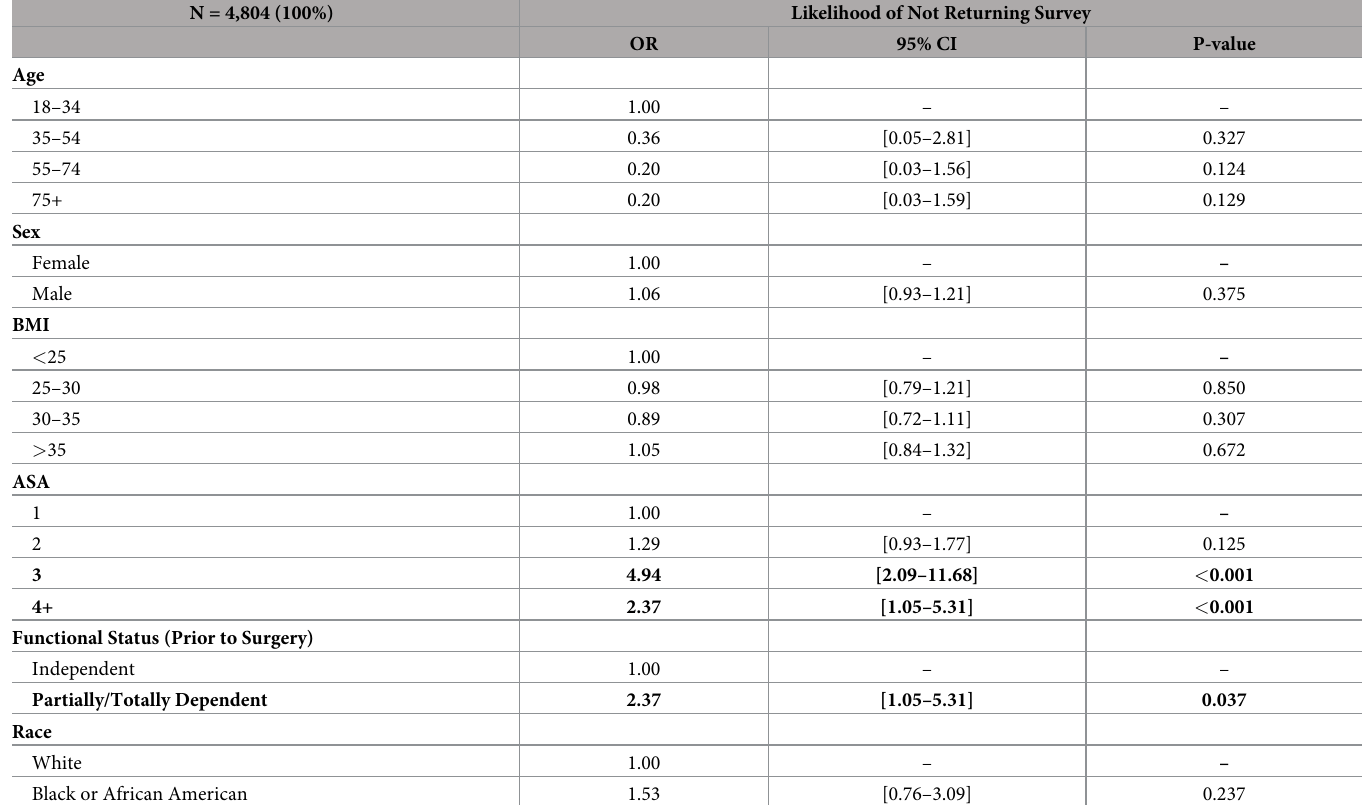
Table 3. Demographic factors associated with not returning the HCAHPS survey in patients undergoing primary TKA. N = 4,804 (100%)